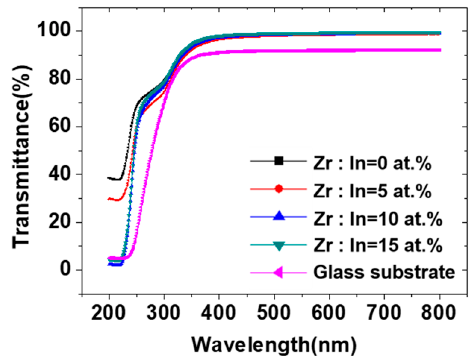
Figure 9. Transmittance of different doping ratio films changes with the wavelength under 400 °C.